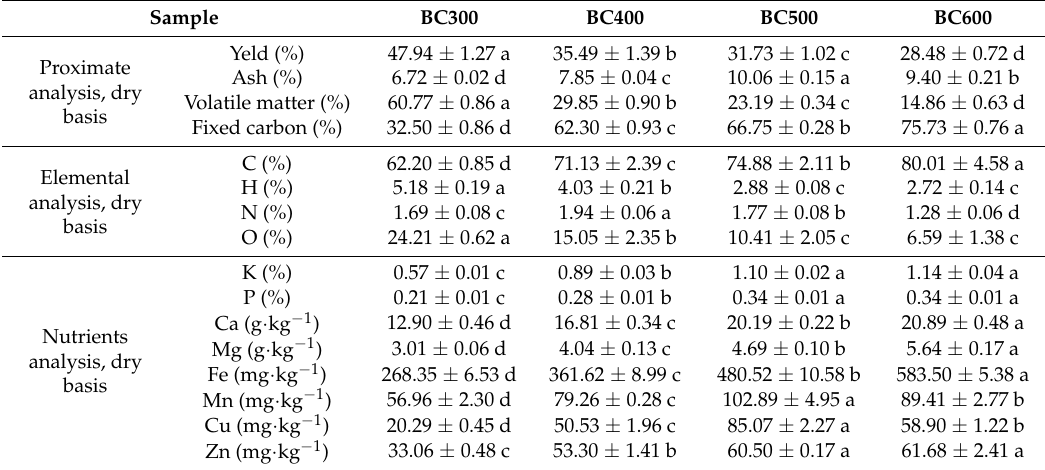
Table 1. Proximate, elemental and nutrients analysis of biochars produced at different temperatures.